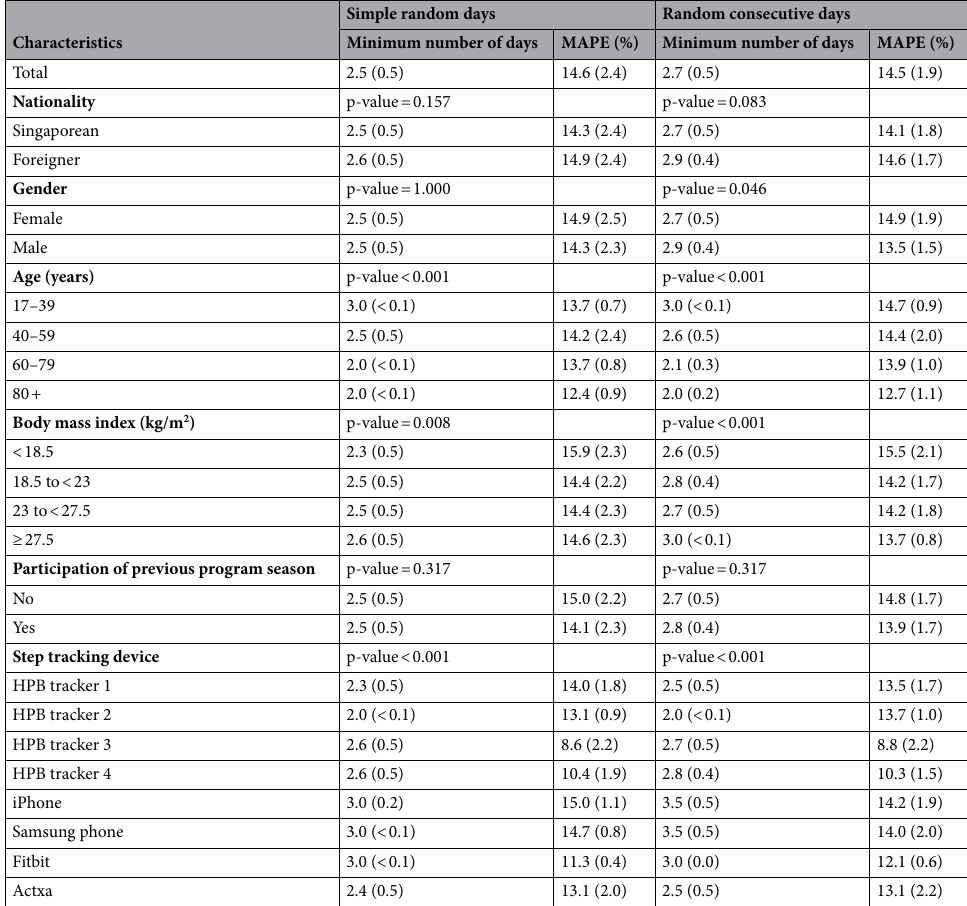
Table 2. Minimum number of days required to estimate weekly level of daily step count with ICC ≥ 80% and the corresponding MAPE (N = 212,048). Data are in mean (SD) of results over 22 separate weeks. p-values were from Friedman’s tests to compare minimum number of days required between participant groups (Supplementary Table S1). ICC intraclass correlation coefficients, MAPE mean absolute percentage errors, HPB Health Promotion